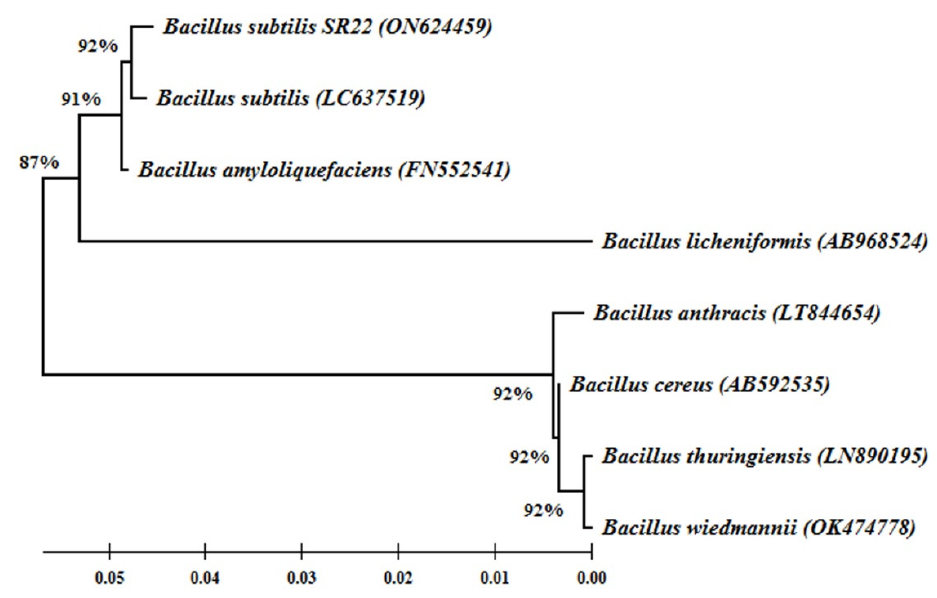
Figure 1. Phylogeny tree showing the relationship between the endophytic Bacillus subtilis SR22 and the closely related strains from the GenBank. Bootstrap values (%) are shown at the branches.